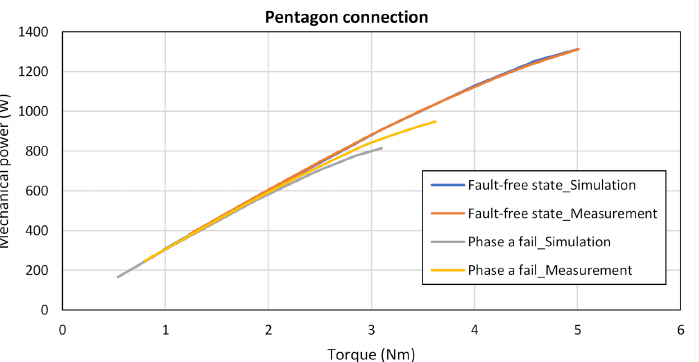
Figure 30. Dependence of phase a motor current on speed for the fault-free state in pentagon connec- tion.